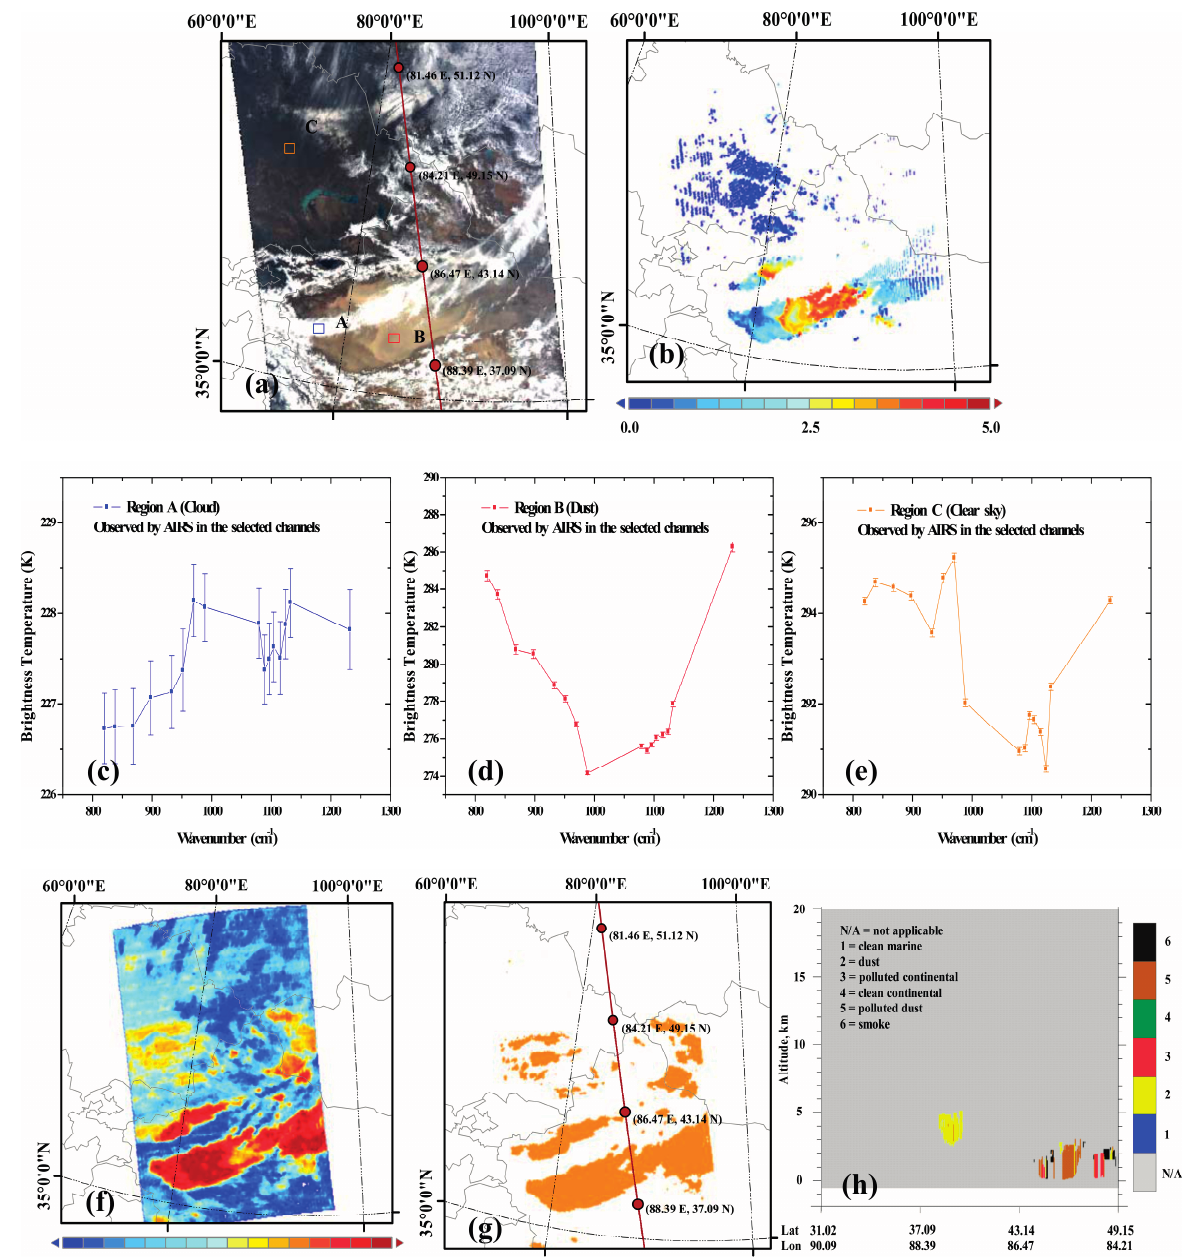
Figure 10. 19 April, 2008 ( a ) MODIS RGB composite image. ( b ) MODIS deep blue aerosol optical depth. ( c ) AIRS observations in cloudy region. ( d ) AIRS observations in dusty region. ( e ) AIRS observations in clear sky region. ( f ) DSSI . ( g ) Dust detection results based on DSSI. ( h ) CALIOP aerosol subtype